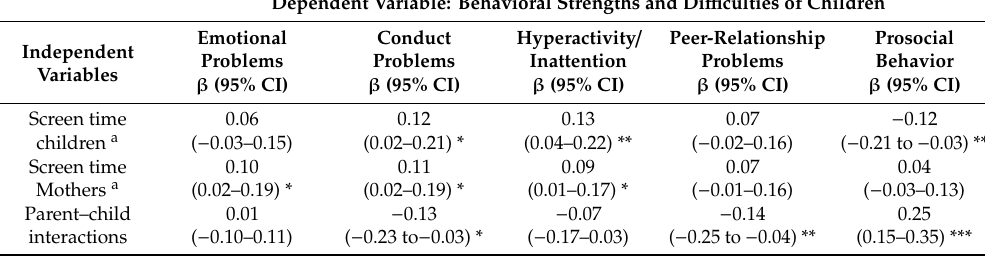
Table 2. Associations of mothers’ and children’s media use and parent–child interactions with behavioral strengths and di ffi culties (n = 553 2- to 9-year-old children and their